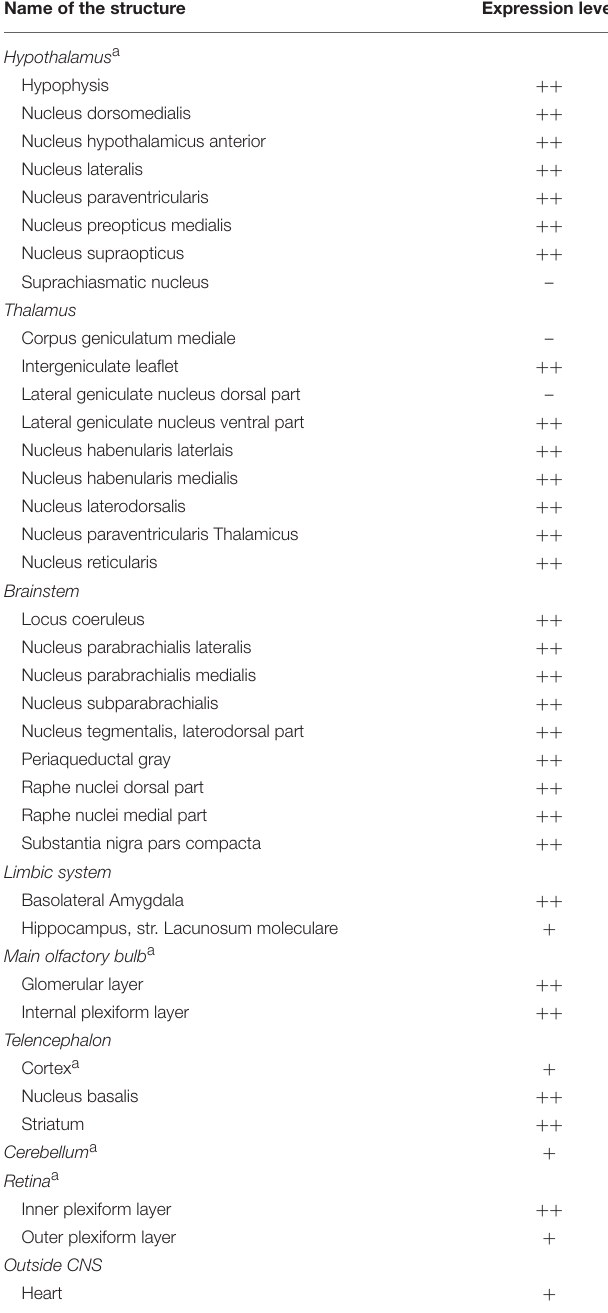
TABLE 2 | Expression of HCN3